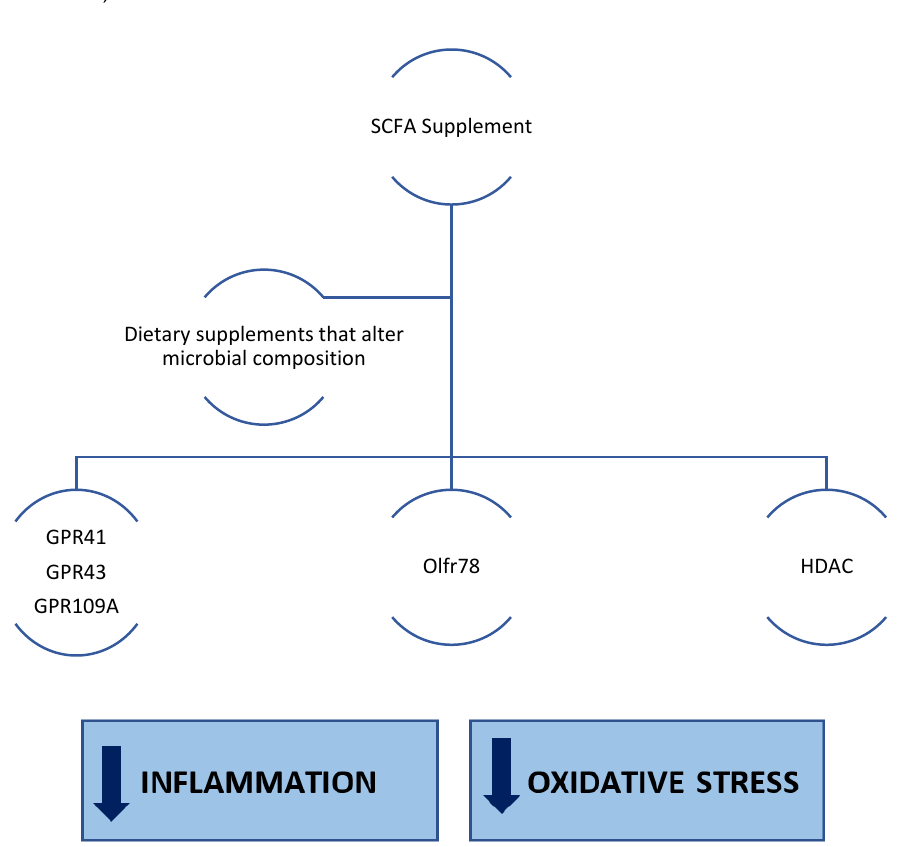
Figure 3. SCFAs result in increased activity on G-protein-coupled receptors and enhanced epigenetic regulatory activity through HDAC. SCFAs could be able to act positively on pro-inflammatory pathways (e.g., by negatively modulating the NF- κ B signalling pathway) and pro-oxidant pathways (e.g., by positively modulating the Nrf2 pathway).